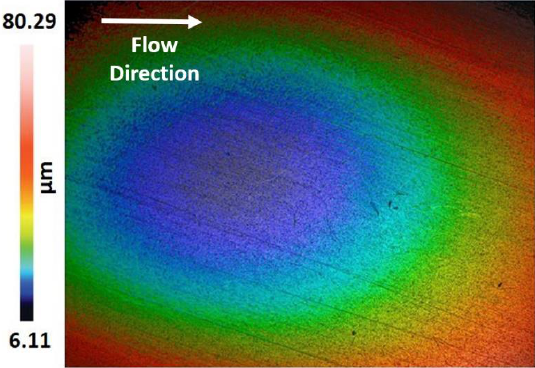
Figure 8. Confocal micrograph of 90° elbow exit section for slug flow without sand particles.